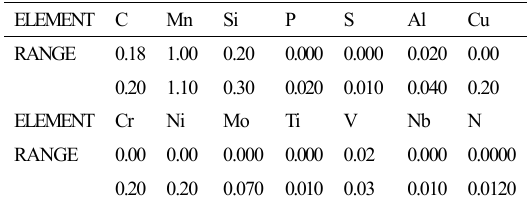
Table 1. Nominal chemical composition of API steel (wt%) 12 .